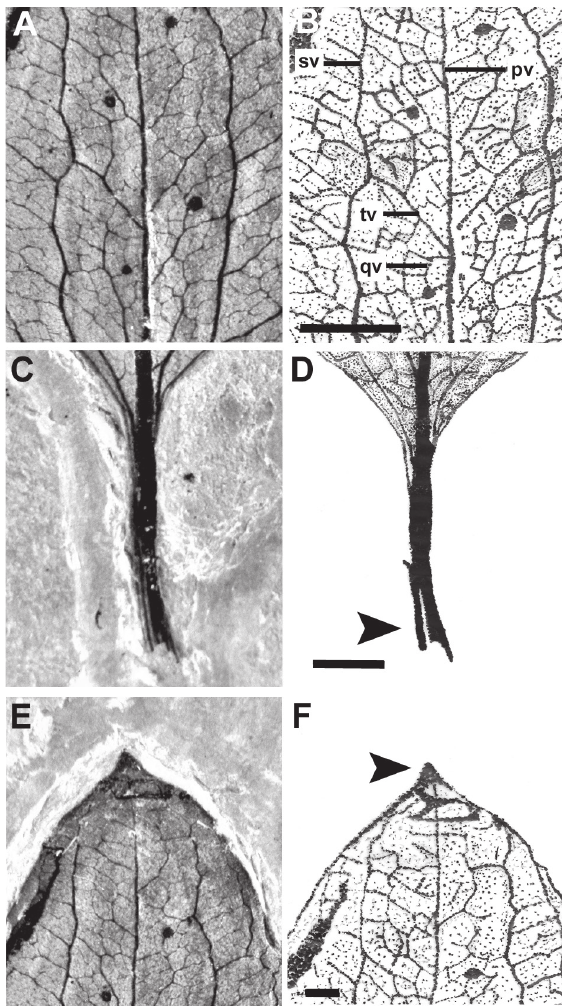
Figure 3 - A. Detail of venation of Cratosmilax jacksoni gen. et sp. nov. B. Drawing showing the presence four orders of venation: pv - primary vein; sv - secondary vein; tv - tertiary vein; qv - quaternary vein. C. The long petiole terminates in a sheath. D. Drawing showing details of the petiole. E. Acute foliar apex. F. Details of the acute apex forming an angle of 70° in the drawing. Scale bars = 10mm in A-B ; 5mm in C-D ; 2mm in E-F